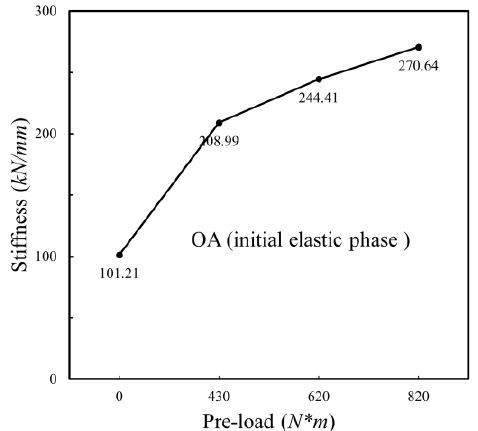
Figure 16. Analysis of the initial stiffness pairs in the elastic phase of the response curves of Tests 1– 4.